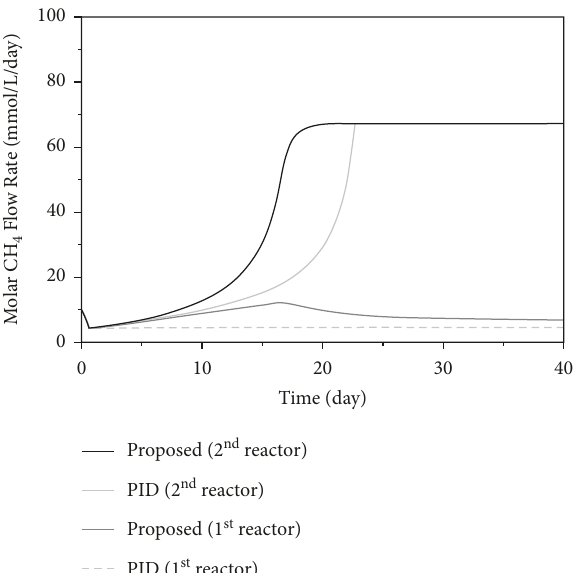
Figure 6: The methane production rate profiles corresponding to the closed-loop system of Figure